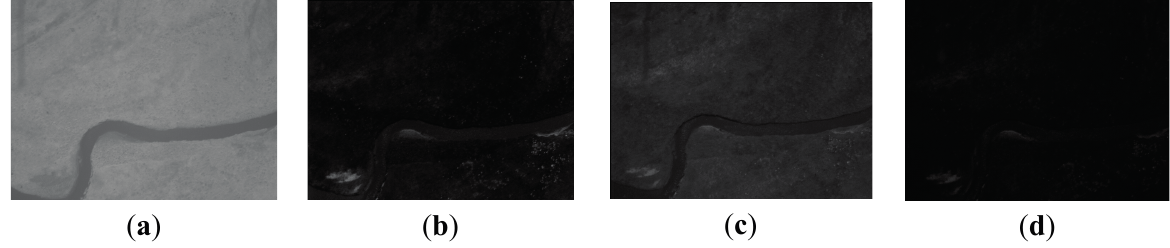
Figure 8. The band images with no artificial objects; ( a ) the infrared band; ( b ) the red band; ( c ) the green band; ( d ) the blue band.